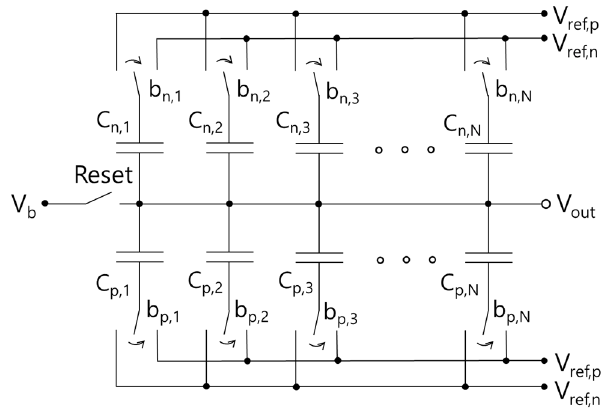
Figure 4. Schematic of a Split-Array C-DAC.